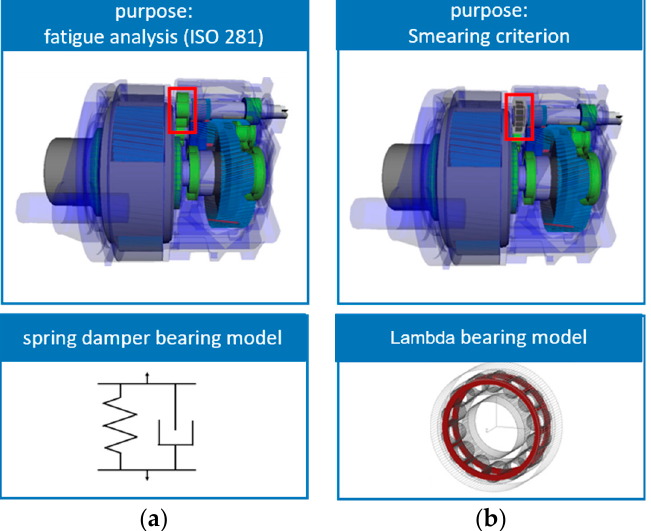
Figure 2. ( a ) A spring damper bearing MBS models within the WT gearbox; ( b ) A Lambda bearing MBS models within the WT gearbox.